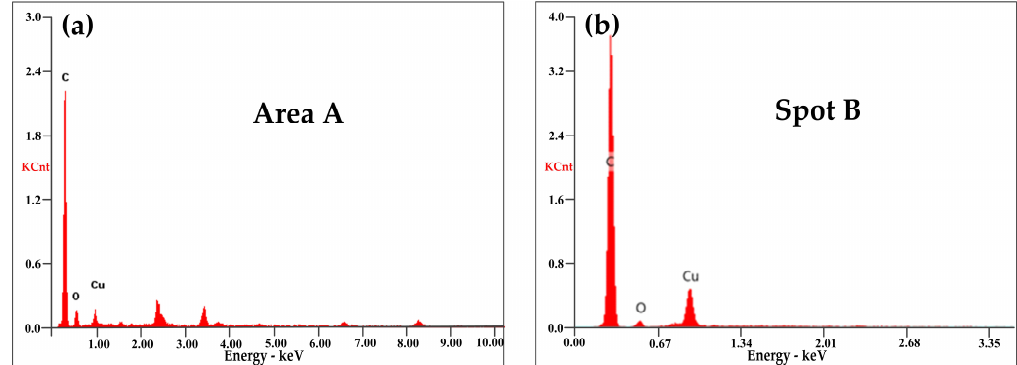
Figure 12. EDX of the selected area: ( a ) ablation products from Figure 11b; ( b ) debris from Figure 11c.